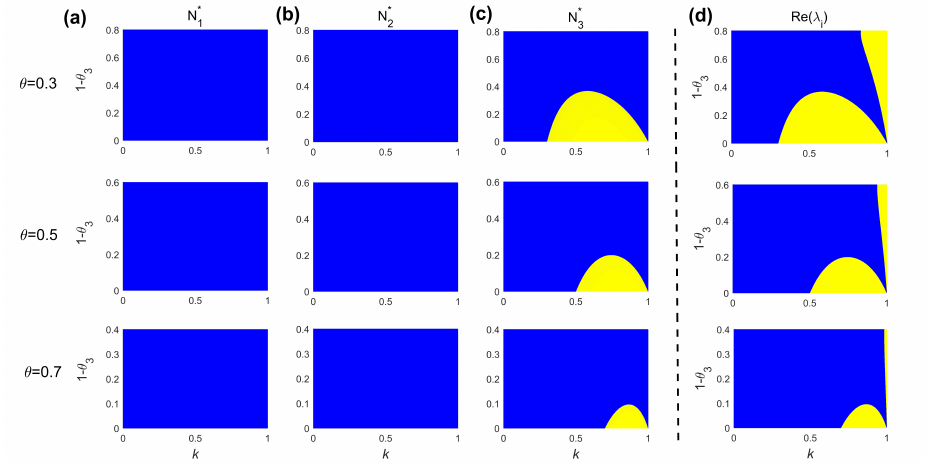
Figure A1. Detail parameter ranges for positive equilibrium states ( a – c ) and for locally asymp- totic stable analysis ( d ). Different figure rows correspond to three levels of competitive symmetry 1 − θ = 0.7, 0.5, 0.3. There were two kinds of ranges: blue colors ( N ∗ and Re ( λ i ) < 0), yellow colors ( N ∗ of all figures in each row to represent the final coexistence area for each competitive symmetry 1 − θ (Figure 2b of main text). Other parameters are r 1 = r 2 = r 3 =